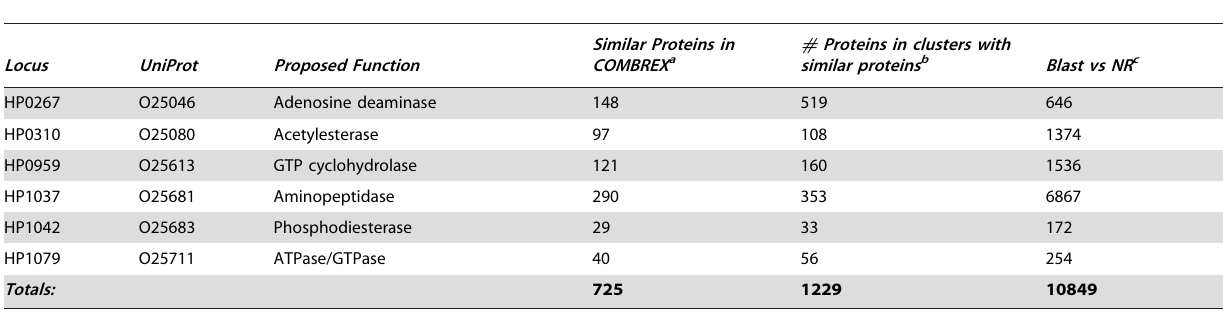
Table 3. Extended impact of genes